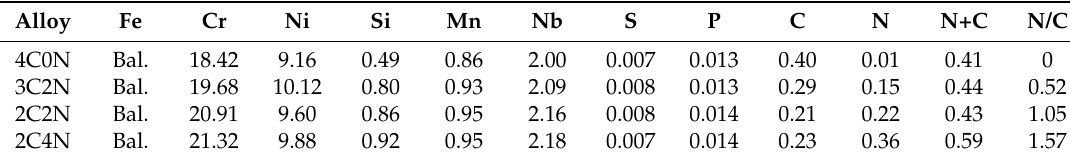
Table 1. Measured chemical compositions of the as-cast alloys (wt